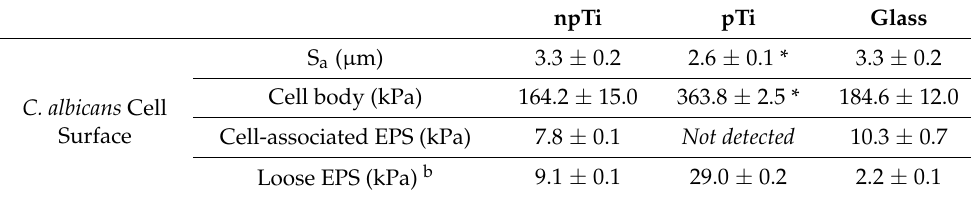
Table 1. Analysis of C. albicans cell mechanical properties on npTi, pTi, and glass surfaces a